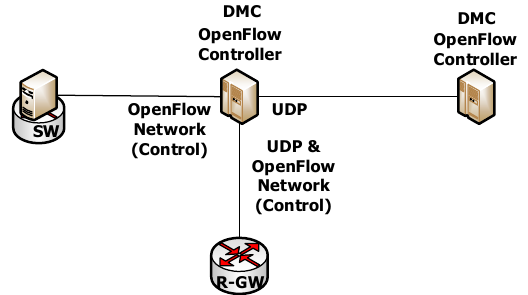
Figure 19. Connection of the distributed mobility controller (DMC) with other entities.